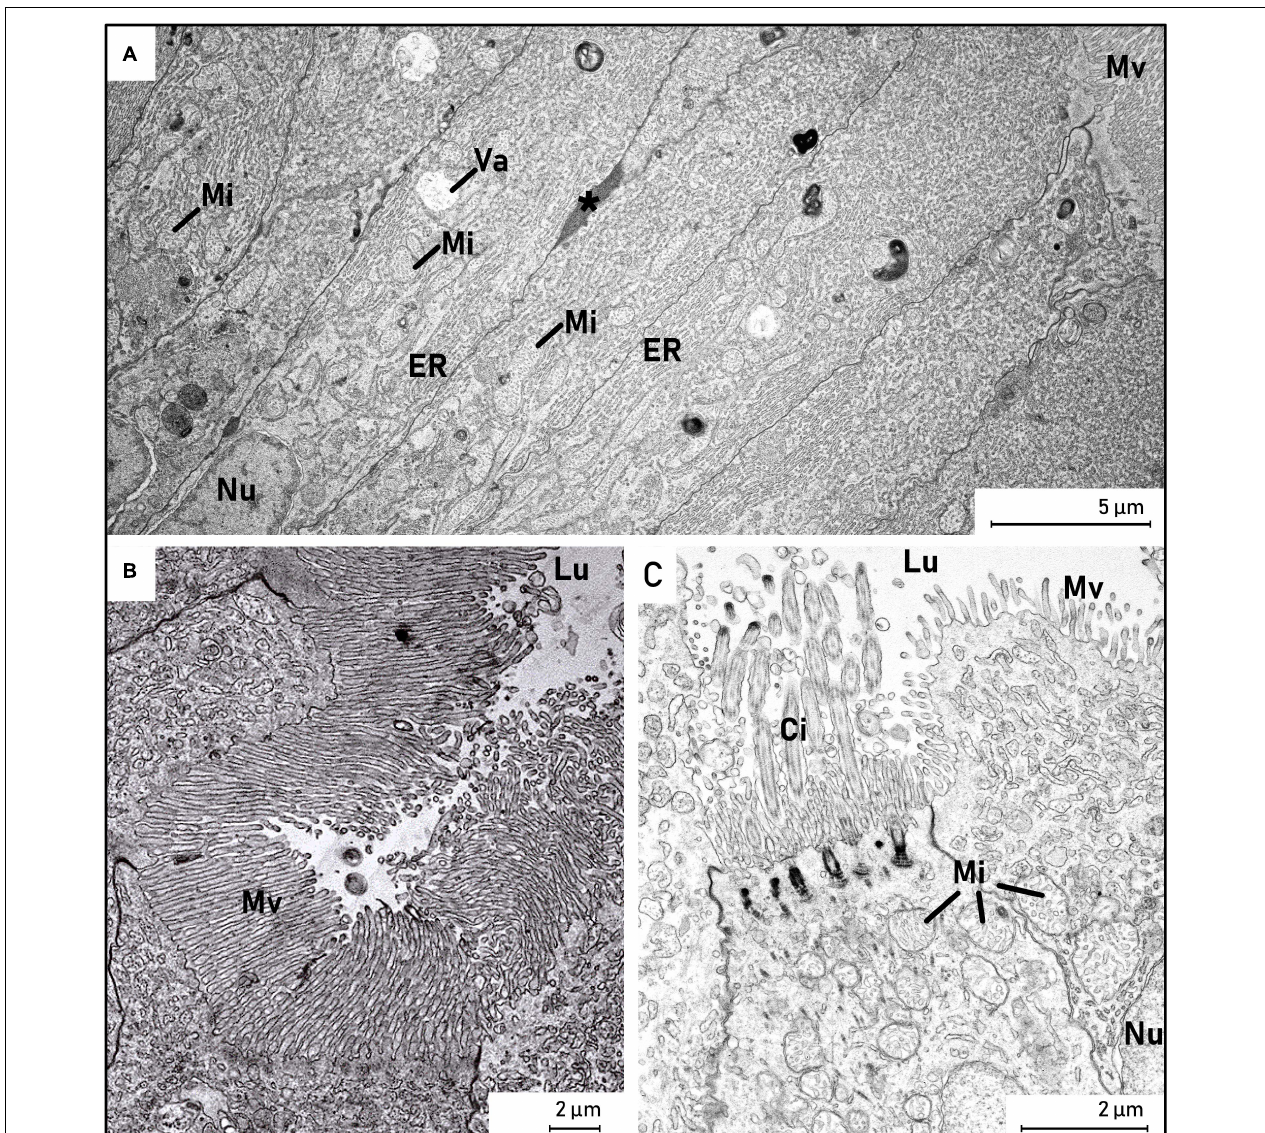
FIGURE 10 | Transmission electron micrograph of enterocytes from a European eel larva ( Anguilla anguilla ) (L21, SL = 23.33). (A,B) The apical part of the columnar enterocytes in the epithelium had large nuclei (Nu) with regular alignment in the basal part of the cells, and microvilli (MV) covered the luminal side of the epithelial cells. The enterocytes were characterized by oblong mitochondria (Mi) and much endoplasmic reticulum (ER), and some absorptive vacuoles (Va) were observed in the cytoplasm. Nutrient-like transport could be seen in between the intestinal epithelial cells (*). (C) The dorsal part of the intestinal epithelium, where some cells were ciliated (Ci). Abbreviations: (*), lipid-like transport; Ci, cilia; ER, endoplasmic reticulum; Lu, lumen; Mi, mitochondria; Mv, microvilli; Nu, nucleus; Va,